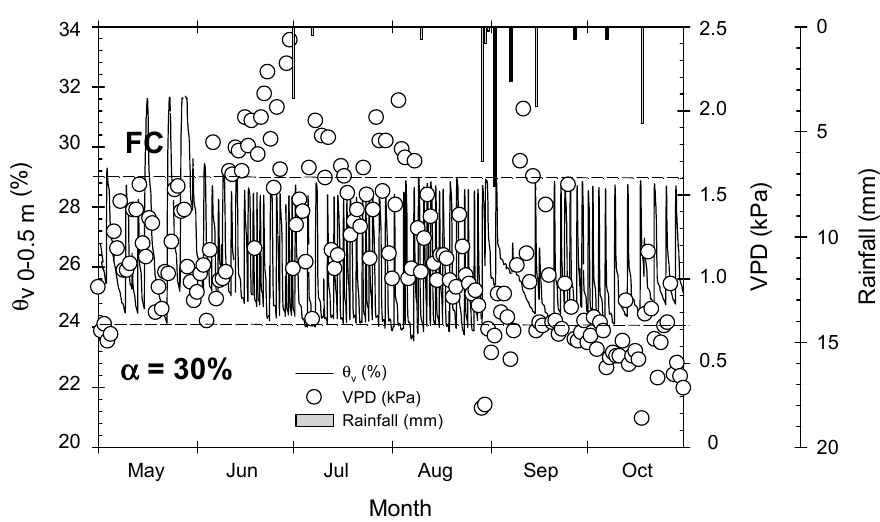
Figure 7. Soil water content ( θ v , %) at 0–0.5 m soil depth during the postharvest period (May to October, 2017) in the moderate water deficit treatment (T–M). Values are the 15-min records corresponding to the average of four probes. Dashed horizontal lines delimit the field capacity (FC) and the soil water deficit ( α ) imposed. White points indicate daily vapor pressure values (VPD, kPa). Vertical bars indicate daily rainfall.